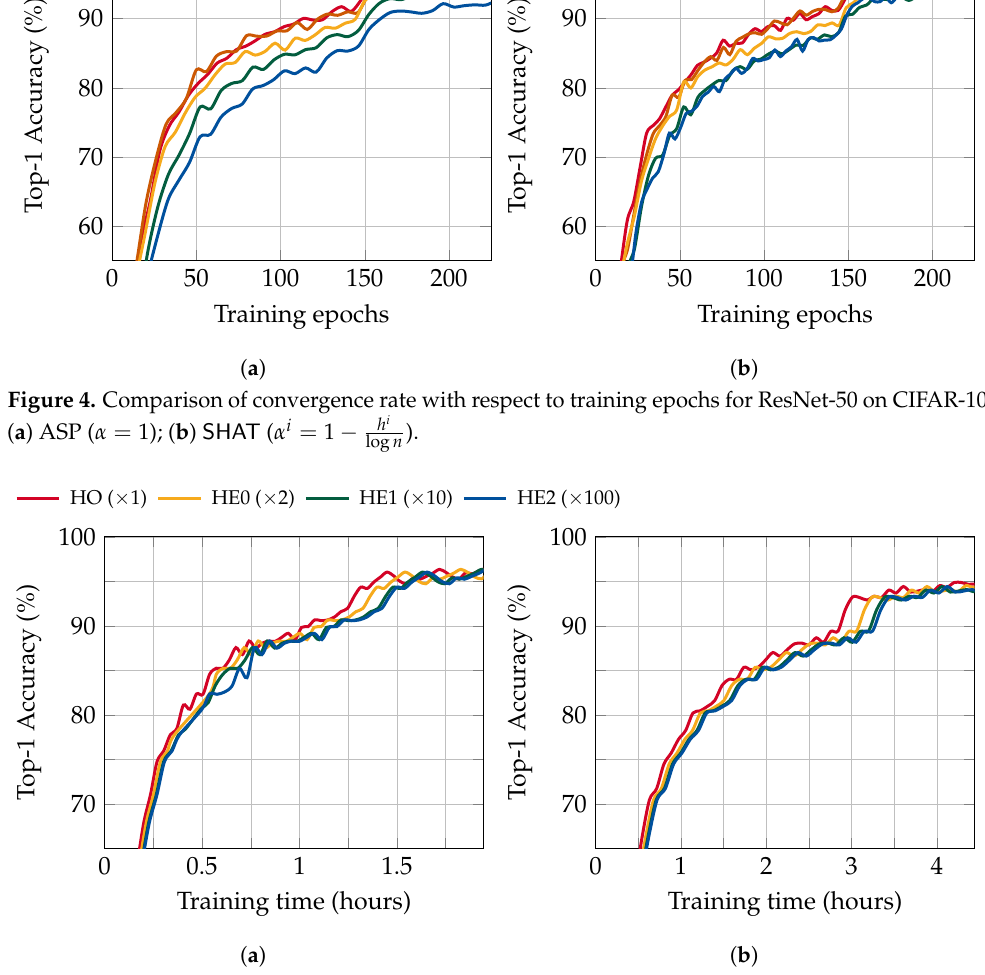
Figure 5. Convergence rate of SHAT under three different heterogeneous clusters; ( a ) ResNet-50; ( b )